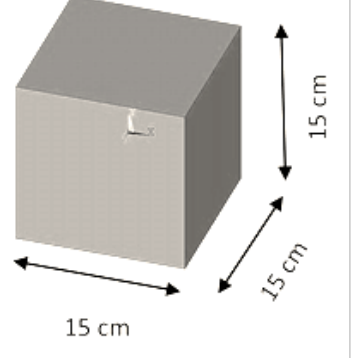
Fig. 1. Three-D Model of test specimen.